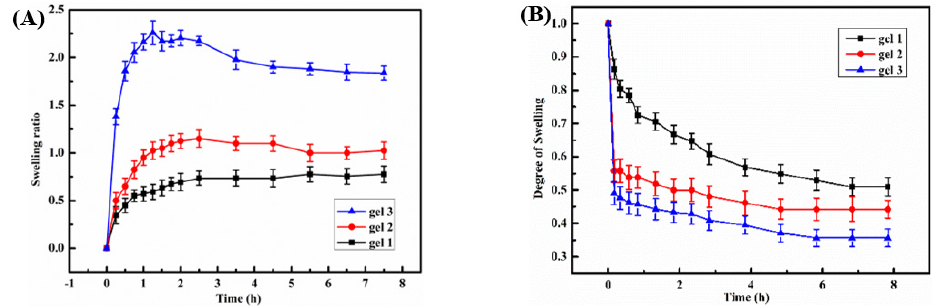
Figure 2. Swelling ratio of hydrogels at 25 ◦ C, pH = 7.4 ( A ) and deswelling ratio of hydrogels at 37 ◦ C, pH = 7.4 ( B ).